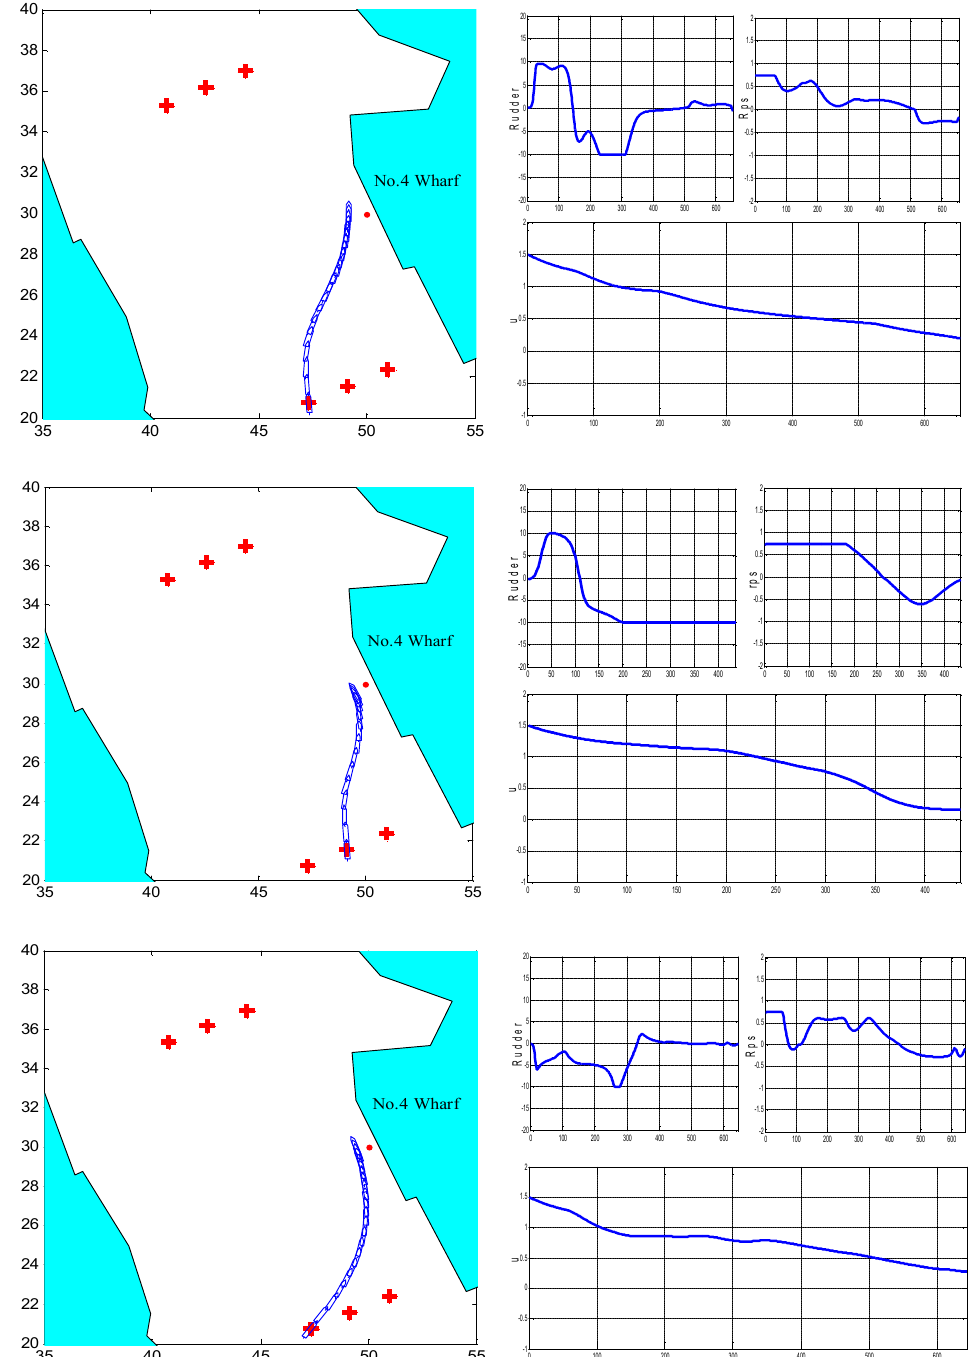
Figure 16. Automatic ship berthing for No.4 Wharf approaching from the starboard side .